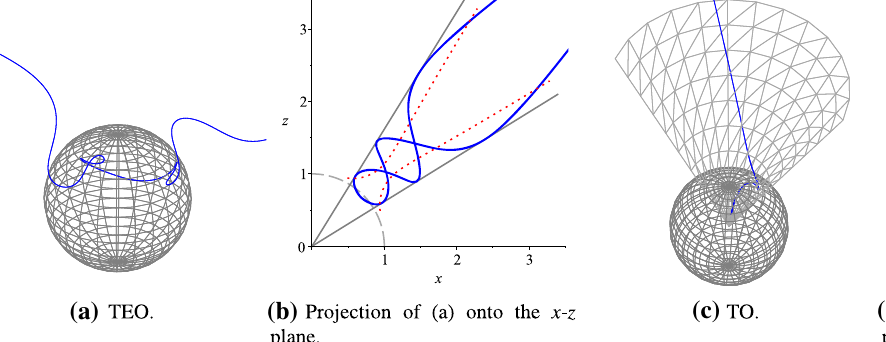
opening angle θ < π/ 2. The corresponding effective potential of the r motion can be found in Fig. 5a. The spheres and dashed circles show the horizon at R =